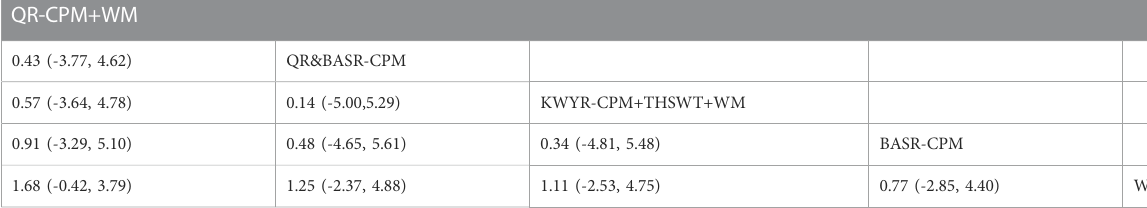
TABLE 11 Results of network meta-analysis for 6-MWT.